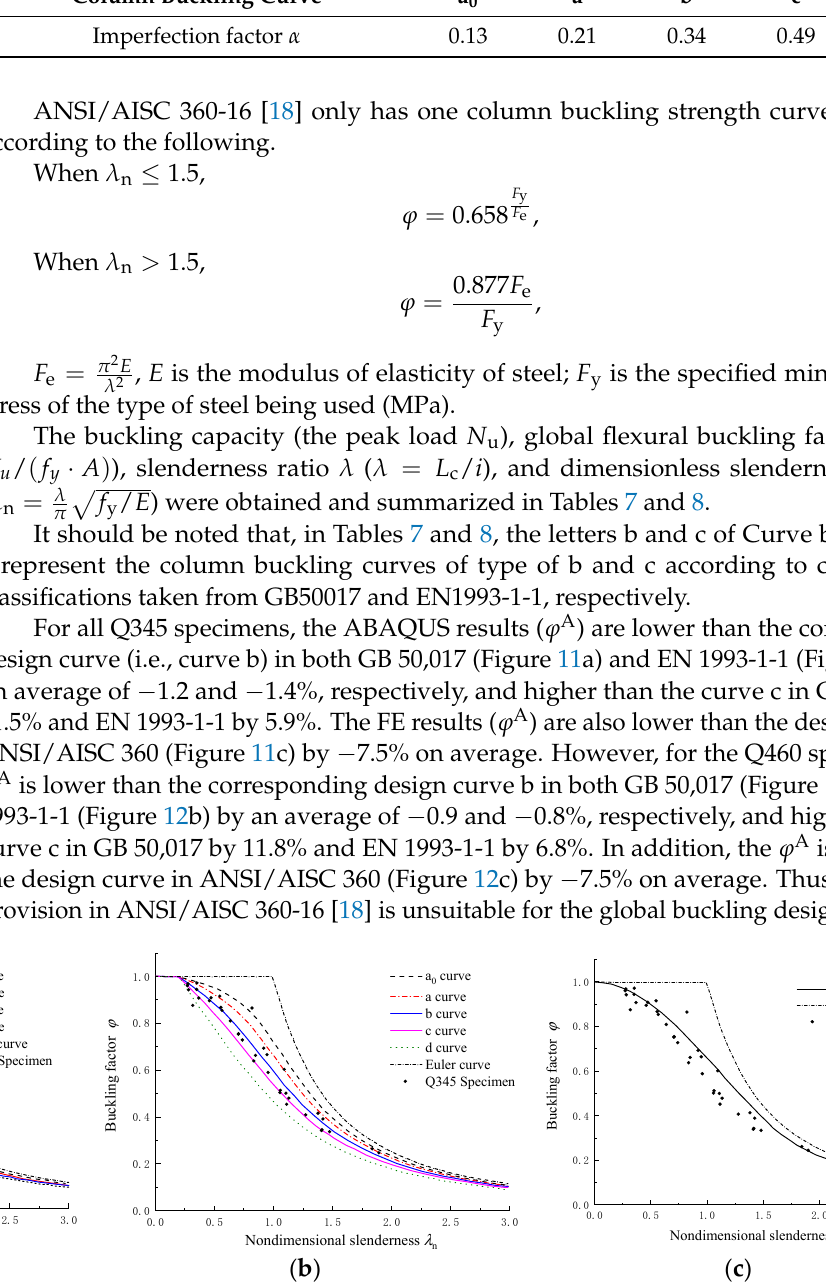
Figure 12. Comparison of FE results with design curves for Q460 specimens: ( a ) GB50017; ( b ) EN1993-1-1; ( c ) ANSI/AISC360.